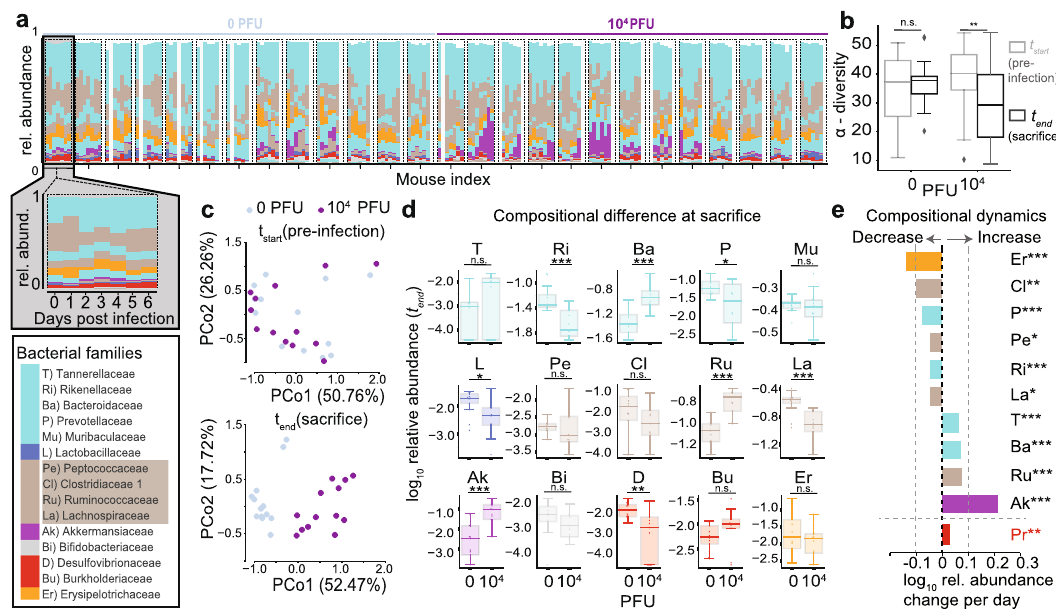
Fig. 1 | SARS-CoV-2 infection causes gut microbiome alterations in mice. K18- hACE2 mice were infected intranasally with 0 or 10 4 PFU of SARS-CoV-2. Fecal samplesformicrobiomeanalyseswerecollecteddailyfromday0(beforeinfection) until sacri fi ce; mice were sacri fi ced on days 5 – 7. Results show pooled data from three independent experiments with n =3 – 5 mice per group. a Timelines of fecal microbiota composition measured by 16S rRNA gene sequencing. Bars represent thecompositionofthe15mostabundantbacterialfamiliespersampleforeachday, blocks of samples correspond to an individual mouse ’ s time course from day 0 to day 6, asexempli fi ed forthe fi rst mouse. b α -diversity (inverse Simpson index) per infection group in the beginning ( t start , n =13 each for control and infected) and at the end ( t end , n =13 each for control and infected) of the experiment (n.s.: non- signi fi cant,**: p <0.01,one-tailed,paired t -test;boxplotsshowmedianandquartile ranges). Comparison between infected and non-infected mouse microbiomes